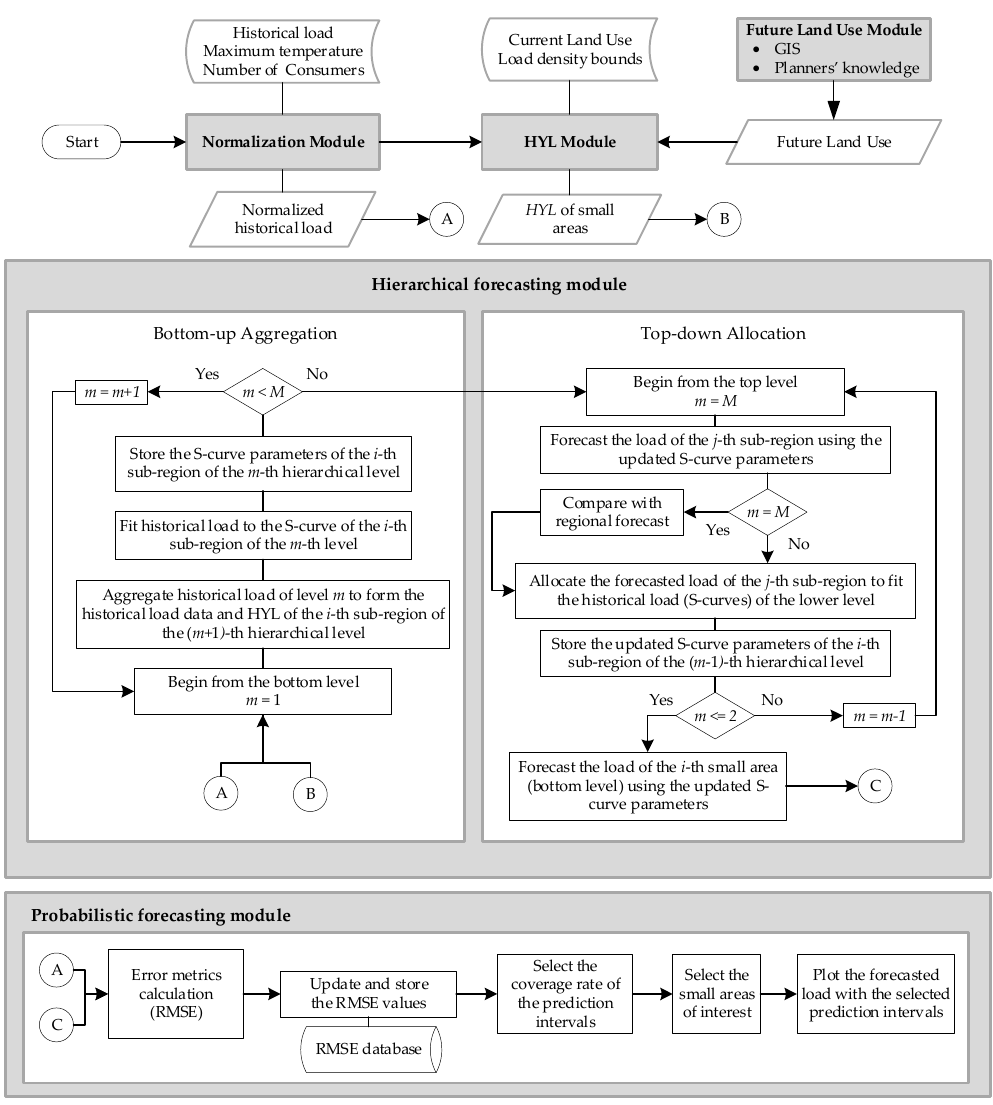
Figure 2. Flowchart of the proposed probabilistic SLF method.